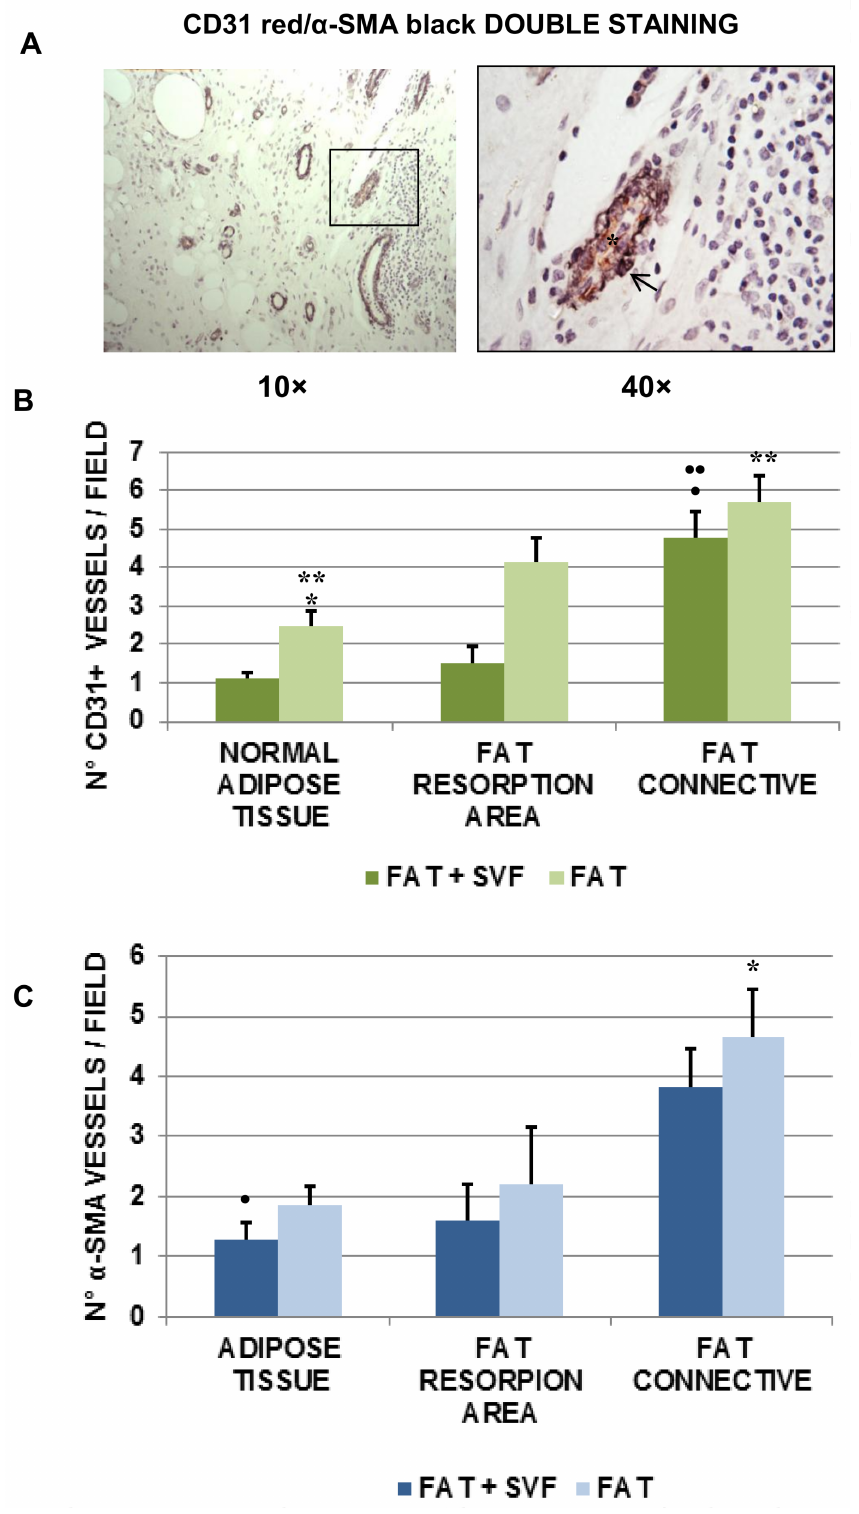
Figure 6. ( A ) Image of double staining red-CD31+ (star; novared as chromogen) and black- α -SMA+ (arrow; DAB-Nickel as chromogen) within a fat biopsy. The double stain shows a red color in the endothelial layer and a black color in the pericytic layer (4 × inset). To evaluate the level of angiogenesis, both CD31 and α -SMA+ vessel density were considered. ( B ) The scoring for CD31+ vessel alone. ( C ) The scoring for α -SMA+ vessel alone. The symbols *, **, • , •• indicate the